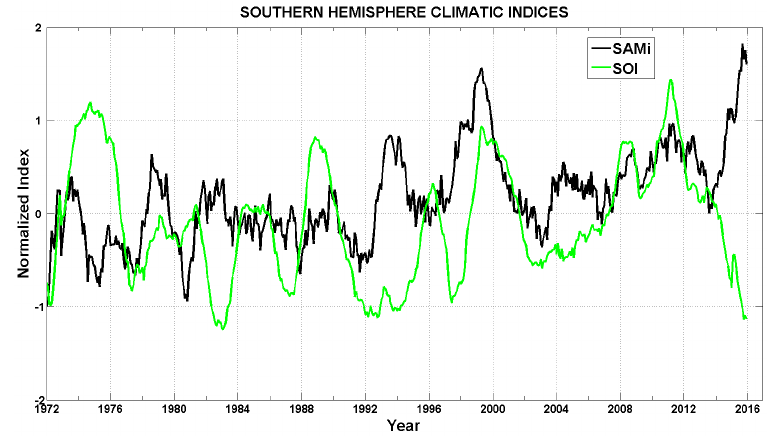
Figure 2. SOI (green) and SAMi (black) during the 1972–2015 period filtered through a twelve month running mean.